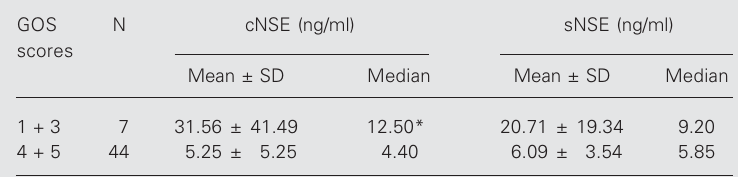
Table 3. Distribution of neuron-specific enolase (NSE) levels according to Glasgow Outcome Scale (GOS)